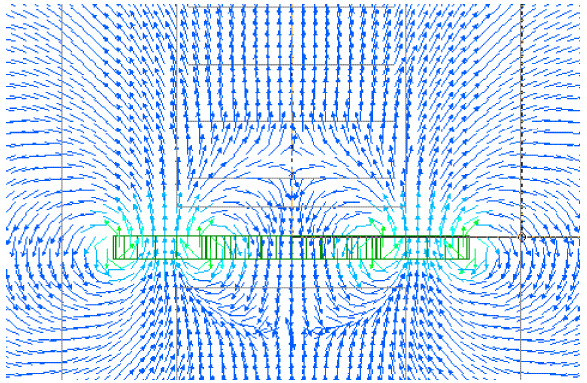
Figure 13. The vector of the magnetic flux density generated by a ring-shaped magnet.